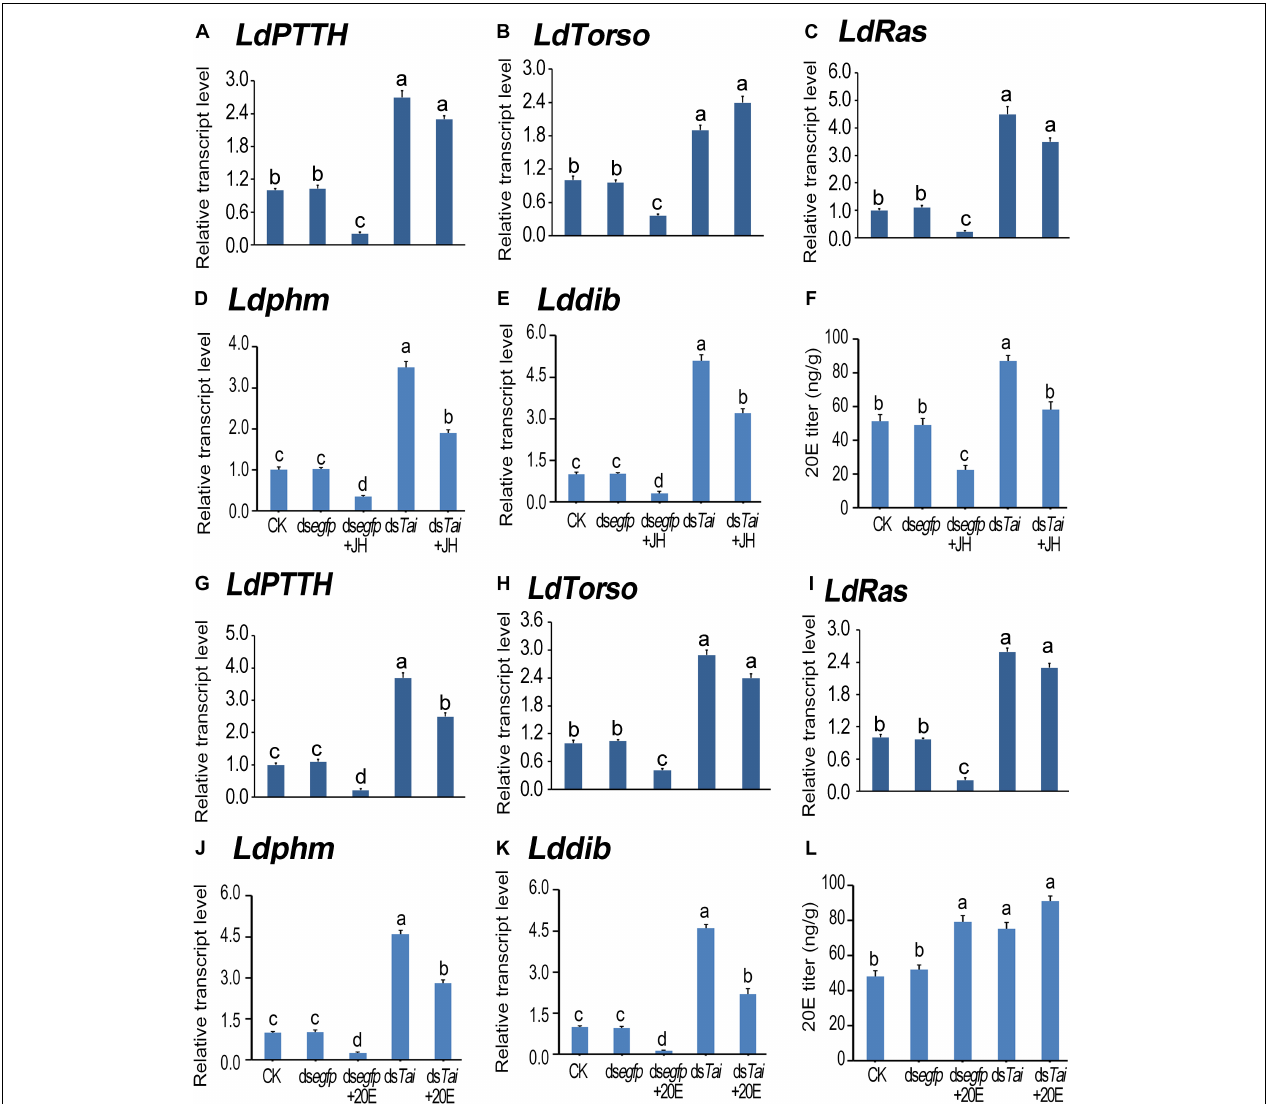
FIGURE 5 | Silence of LdTai affects ecdysteroidogenesis in Leptinotarsa decemlineata . The newly ecdysed final instar larvae had ingested PBS (CK)-, ds egfp -, JH-, ds Tai - and ds Tai +JH-dipped leaves, or PBS (CK)-, ds egfp -, 20E-, ds Tai - and ds Tai +20E-immersed foliage for 3 days. The mRNA levels of LdPTTH (A,G) , LdTorso (B,H) , LdRas (C,I) , two Halloween genes Ldphm (D,J) and Lddib (E,K) were tested using qRT-PCR. 20E titer was determined (F,L) . The bars represent average values ( ± SE). Different letters indicate significant difference at P -value <